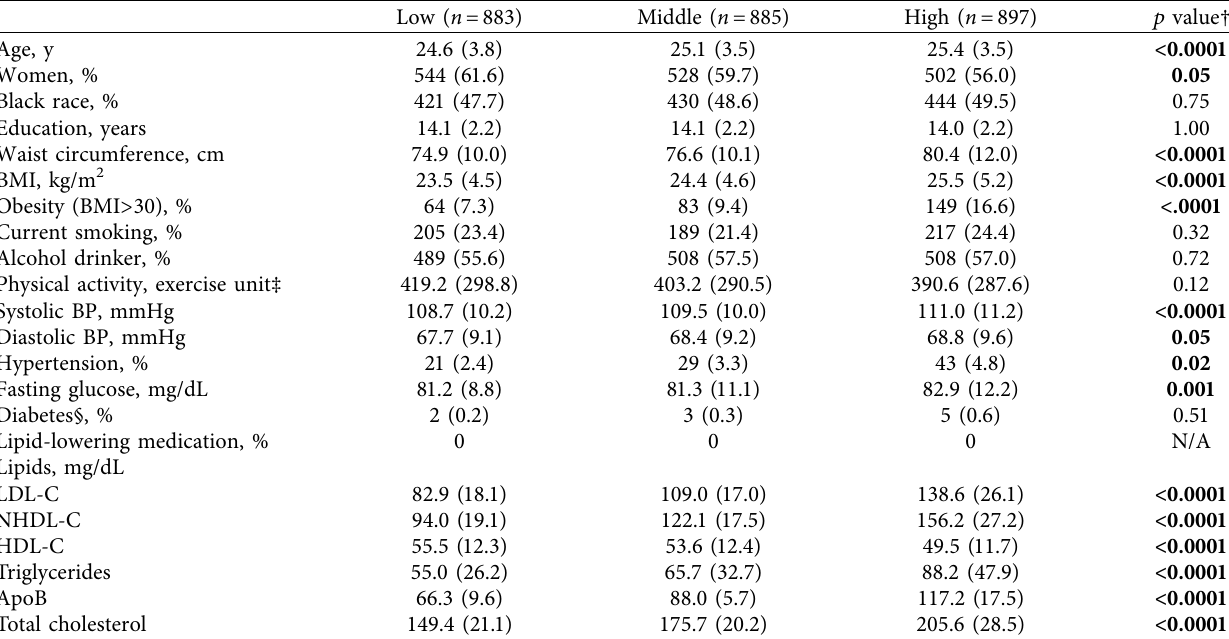
Table 1: Baseline characteristics by apolipoprotein B tertiles ∗ .